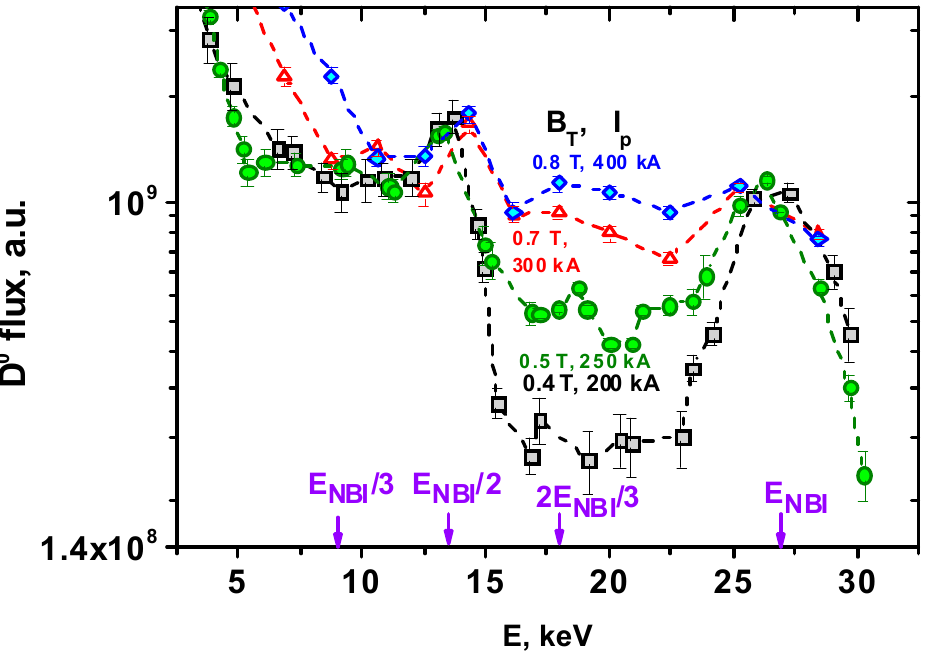
Figure 8. NPA flux, measured in active mode in the discharges with the different B T and I p . For clarity, the spectra are normalized in the region of the injection energy. The figure is taken from [27] and reproduced with permission from IOP Publishing.